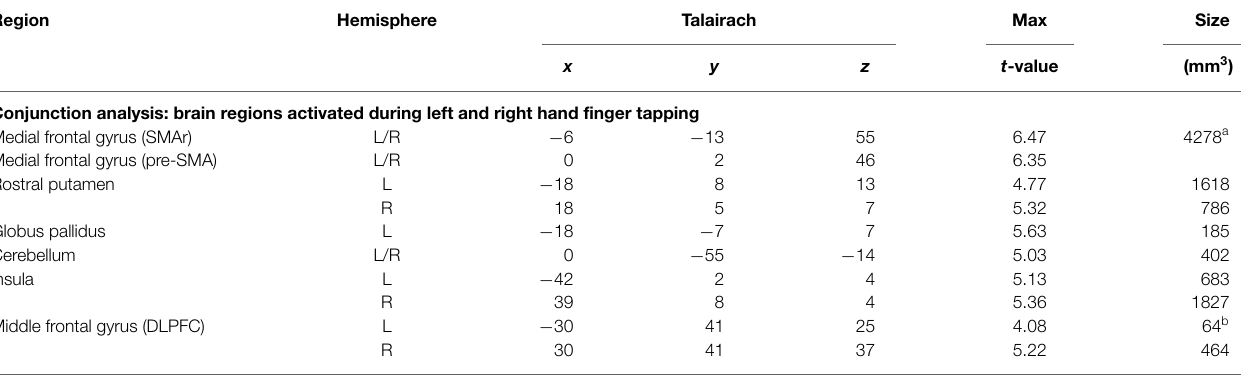
TABLE 2 | Whole brain random effects group analysis; p < 0.001; corrected for multiple comparisons via cluster-size thresholding at 4 voxels (108mm 3 ) . Region